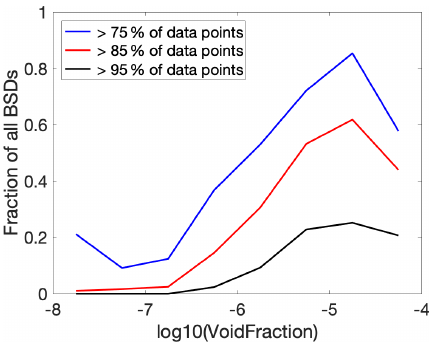
Figure B1. The percentage of data points from each individual nor- malised size distribution which fall between the black lines shown in Fig. 3 was calculated, and the proportion that pass the test for when the criteria is 75%, 85% and 95% is shown here.